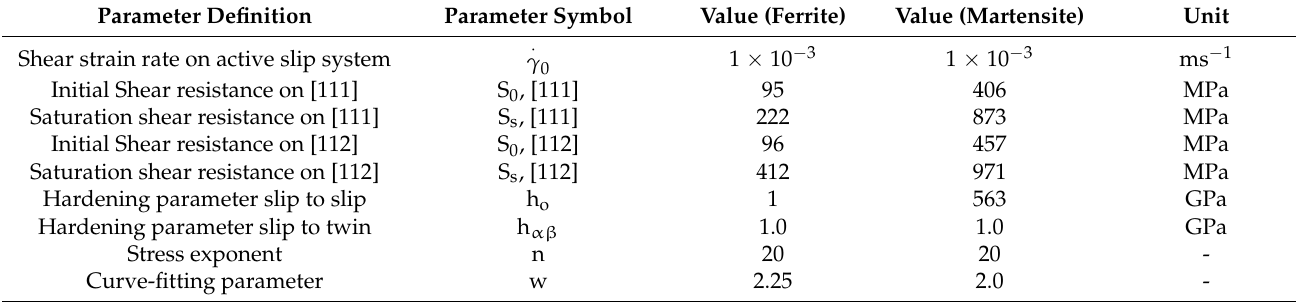
Table 1. Microstructural phase parameters for ferrite and cementite [18,50] with the calibrated fitting parameters for the ferrite phase.